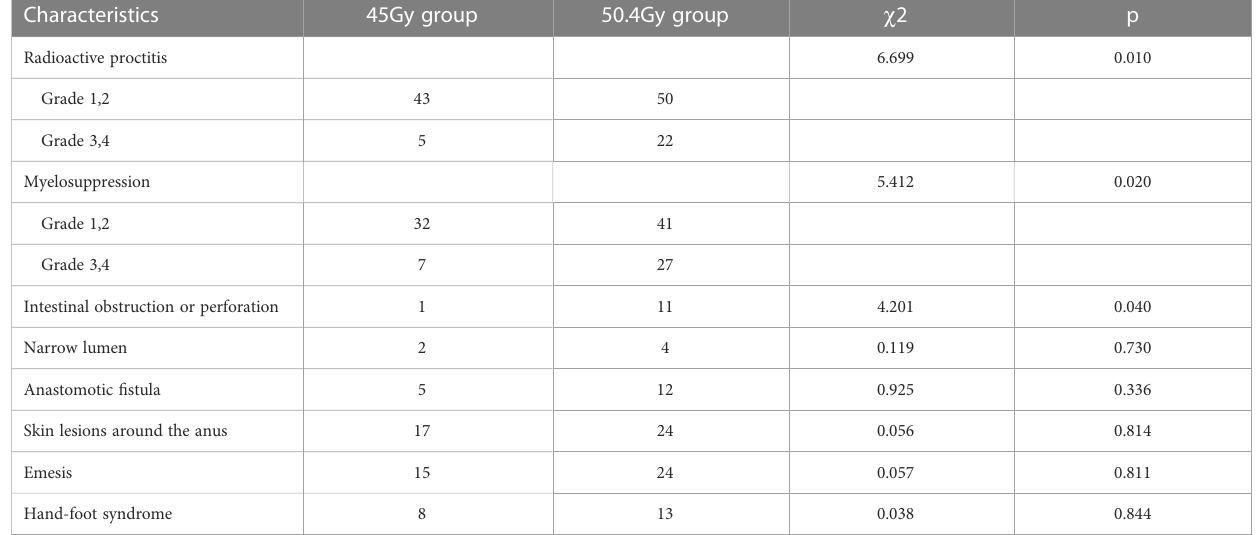
TABLE 6 Adverse reactions to